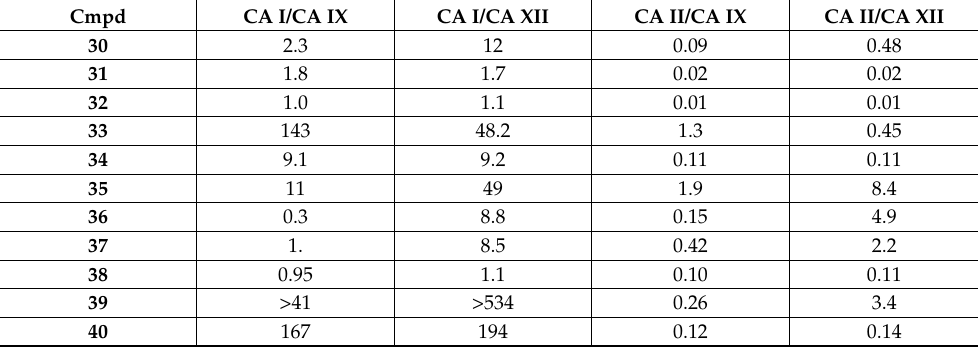
Table 2. Selectivity index ( SI ) calculated for hCA IX and XII over off-targets hCA I and II as ratio between K I